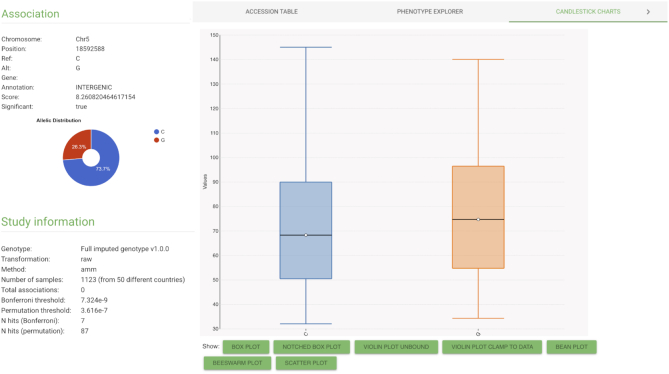

Detailed association view. This view shows detailed information about the alleles and the allelic distribution of phenotypic values for a selected association. The association table gives individual information about each sample, the allele and phenotype value as well as all associated meta-information (e.g. geographic coordinates). All plots can be adjusted dynamically and data can be exported in CSV format directly within the browser (https://aragwas.1001genomes.org/#/study/262/associations/5_18592588).